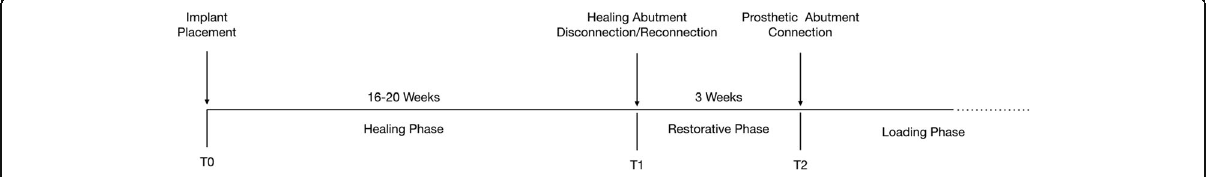
Fig. 1 Overview of the study outline and follow-up